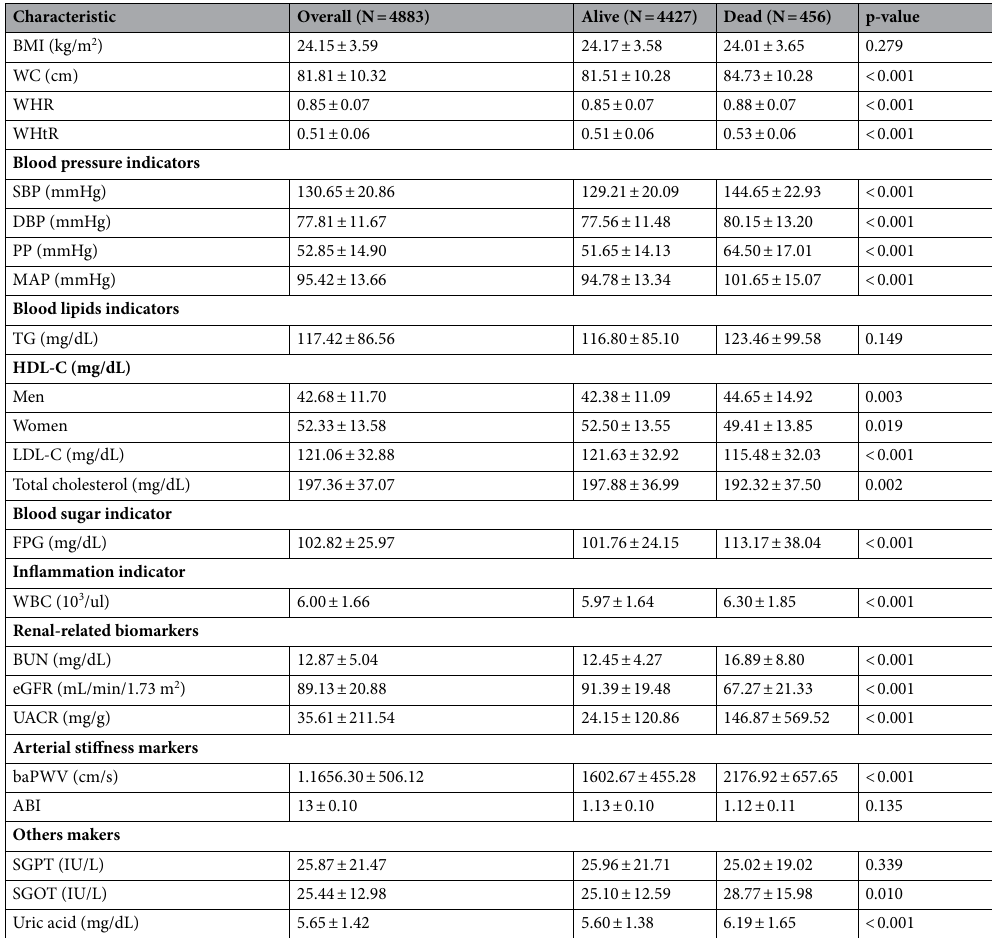
Table 1. Baseline characteristics of sociodemographic factors according to survival status during 8.3 years of follow-up. Data presented as mean ± standard deviation for continuous variables or n (%) for